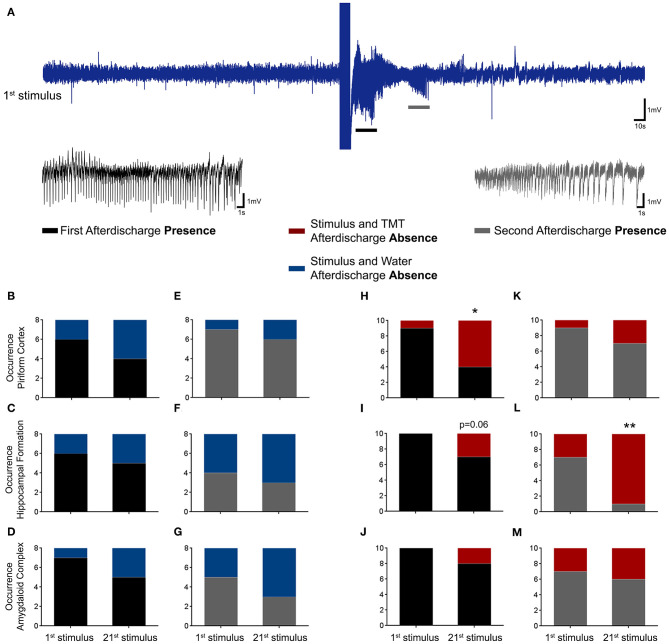
First and second EEG afterdischarges occurrence at the 1st and 21st stimulus for Stimulus and Water, and Stimulus and TMT groups. Upper panel (A) demonstrates a representative raw signal from the 1st stimulus. The inset depicts a typical first (black trace) and second (gray trace) polyspike afterdischarges. The lower panel (graphics) shows the quantification of the afterdischarges presence and absence for the neural structures: piriform cortex, hippocampal formation, and amygdaloid complex. First and second afterdischarges analyses for Stimulus and Water group [first afterdischarge (B–D); second afterdischarge: (E–G)], and Stimulus and TMT group [first afterdischarge: (H–J); second afterdischarge: (K–M)] are presented in sequence. χ2 test, *p < 0.05 and **p < 0.01.